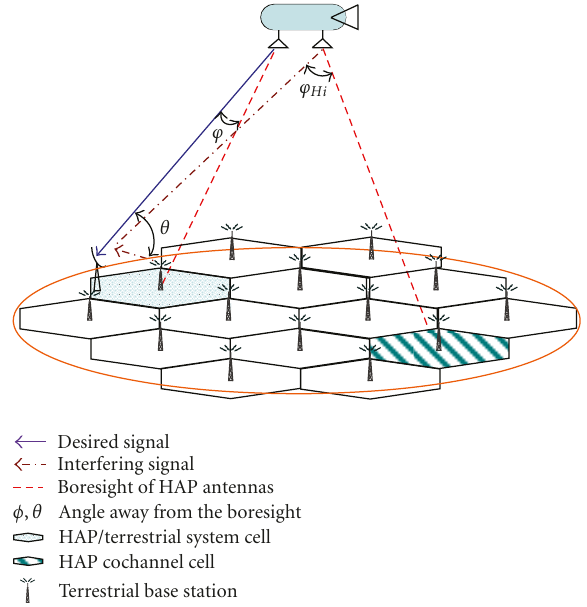
Figure 11: Coexistence model of HAP and terrestrial WiMAX system.